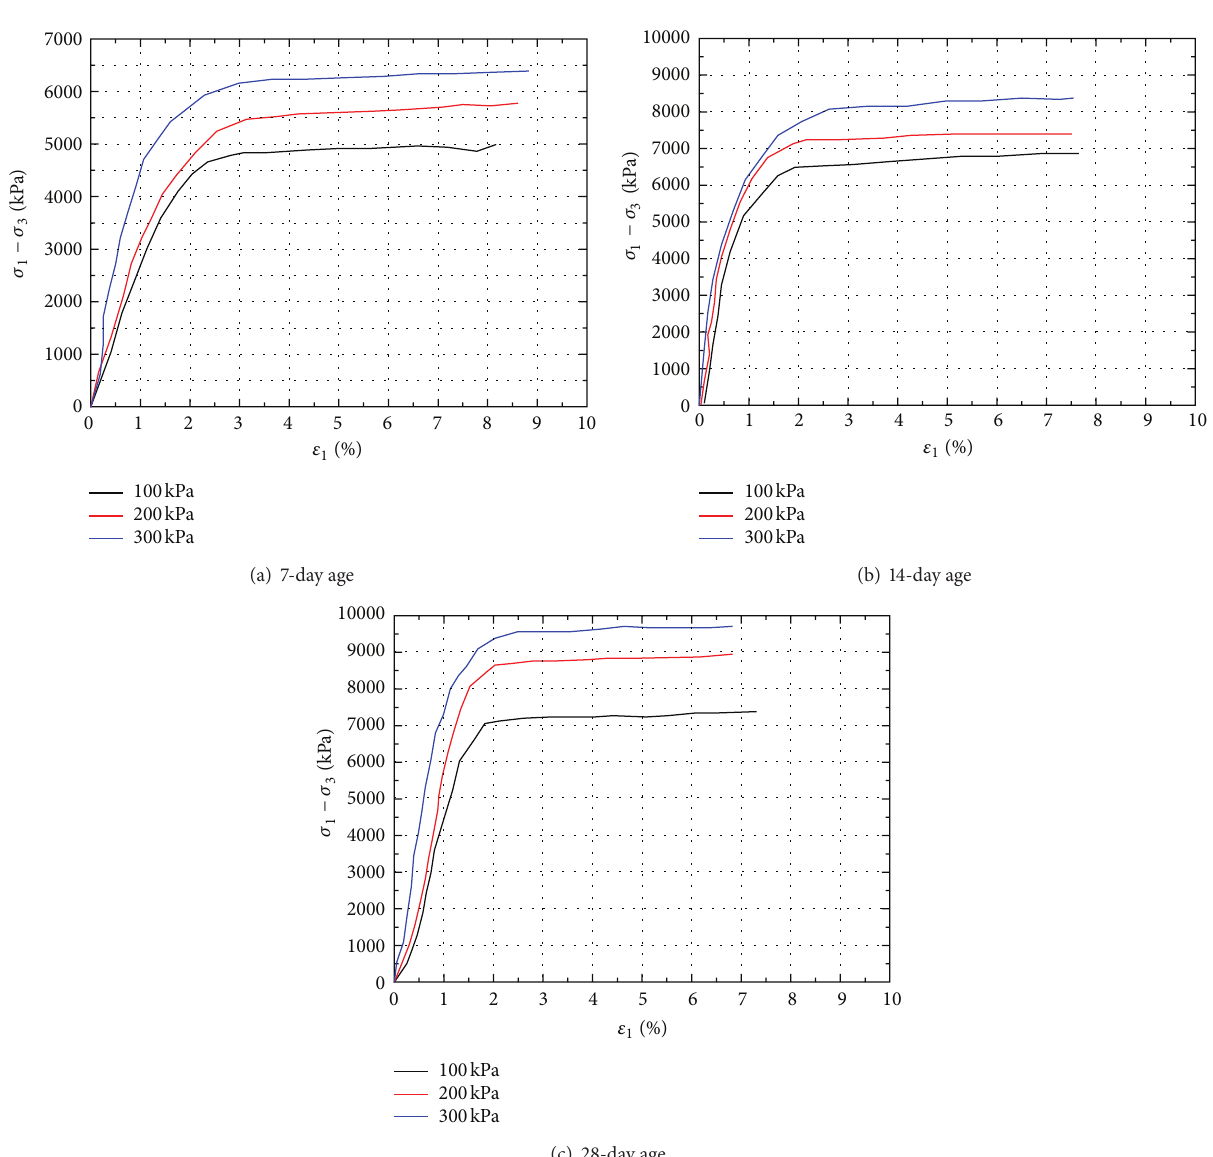
Figure 4: Stress-strain curve of adding 1.0% polypropylene